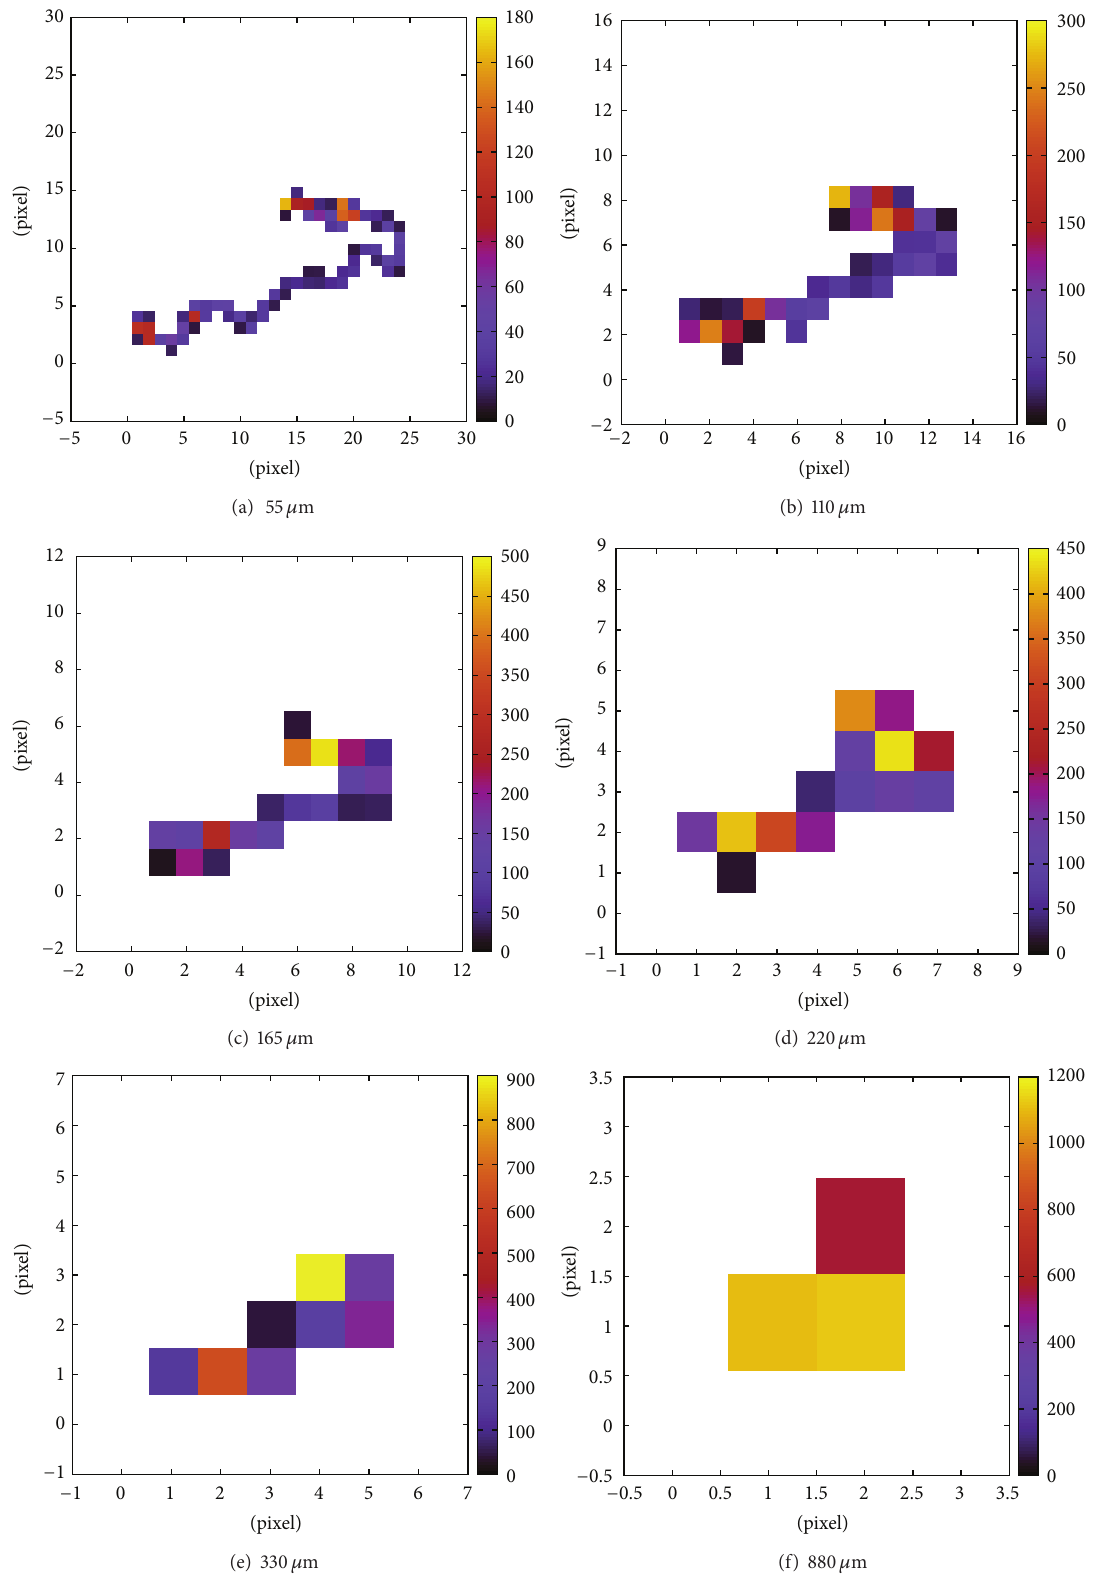
Figure 9: Simulated pattern of energy depositions in the pixel matrix for a 0 ] 𝛽𝛽 -decay event in a 3mm thick CdTe sensor for different granularities of the pixel matrix. The 𝑥 - and 𝑦 -coordinates give the pixel row and column. The color bar encodes the energy deposition measured with the time-over-threshold method in